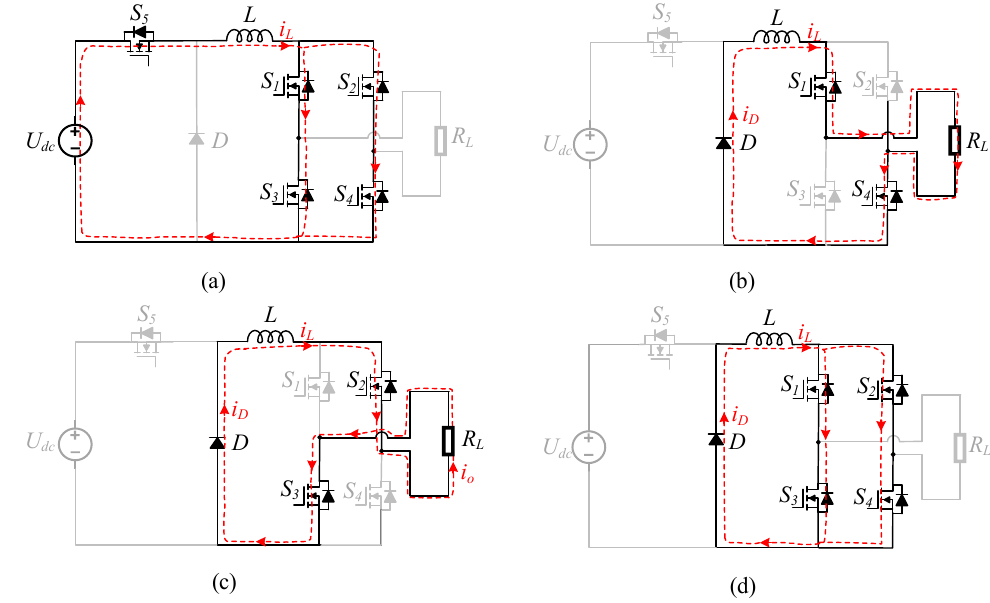
Figure 8. Inverter topology transformation among different stages: ( a ) the charging stage; ( b ) posi- tive pulse; ( c ) negative pulse; ( d ) deadtime.